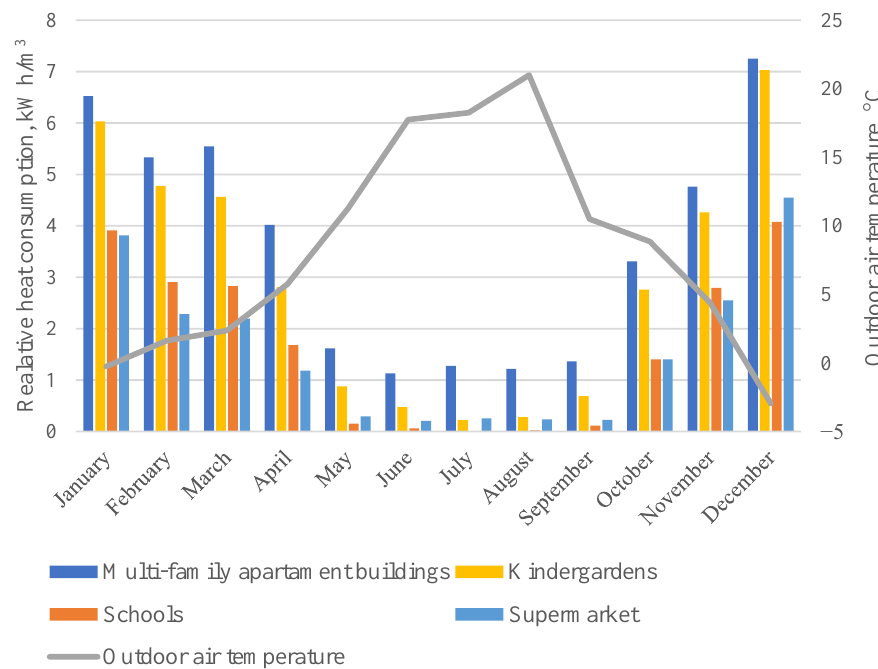
Figure 3. Average relative heat consumption for space heating and hot water preparation in different types of buildings.